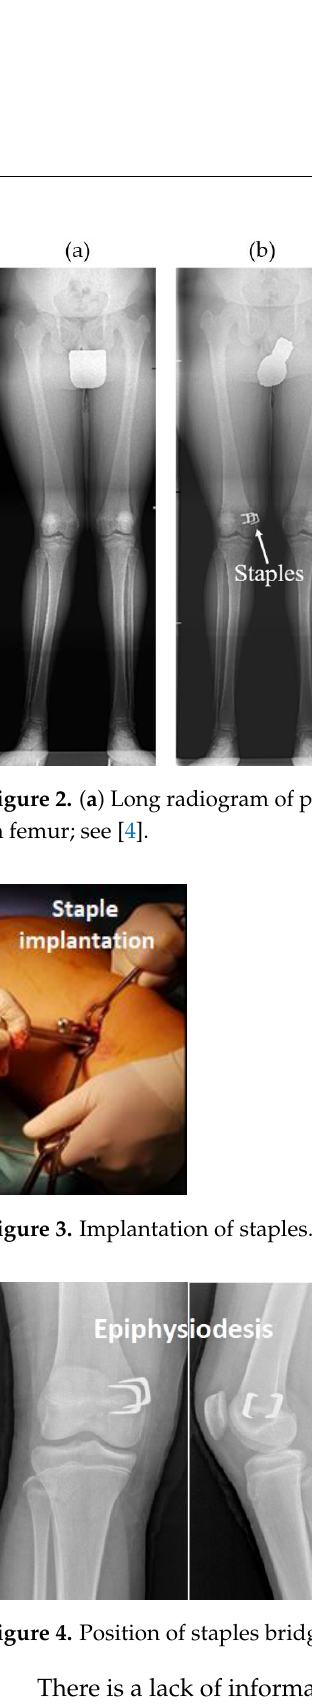
Figure 4. Position of staples bridging the physis in femur.